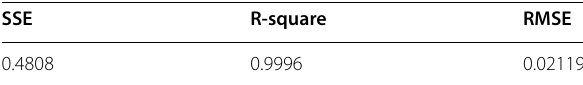
Table 2 Parameter fitting effect